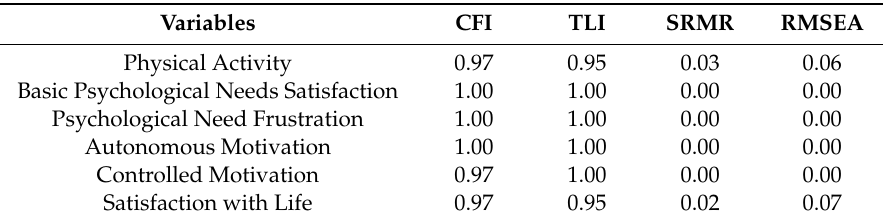
Table 1. Confirmatory factor analysis of all the